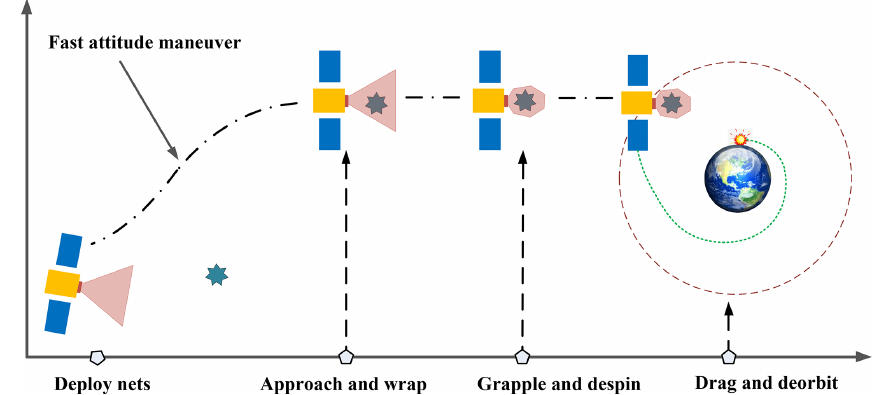
Figure 1. The workflow of SITNCS.